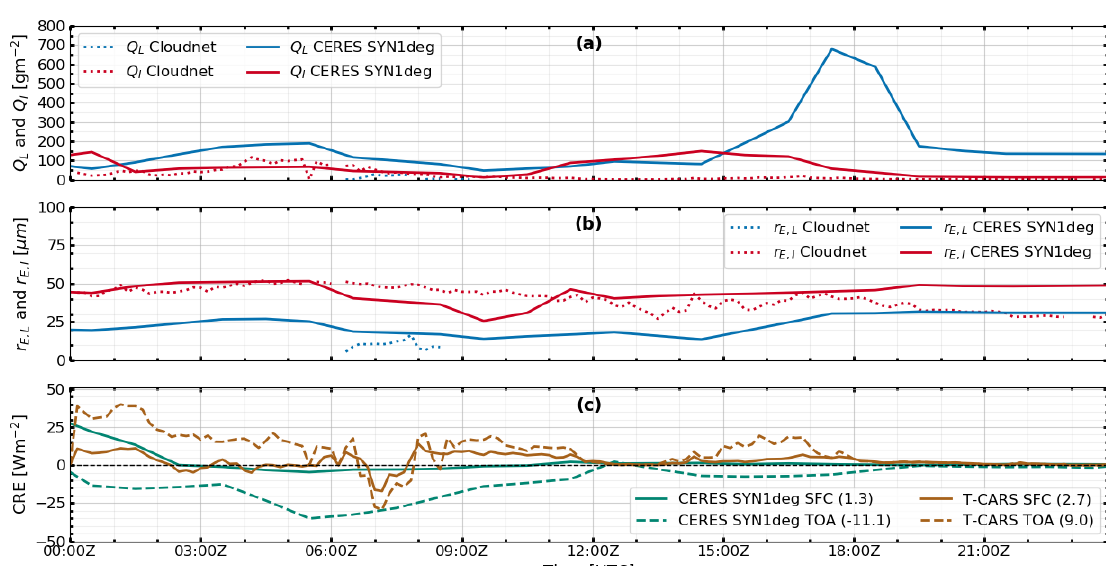
Figure 9. Time series of cloud microphysical properties and CRE between CERES SYN1deg and Cloudnet for the 2 July 2017 case. Panel (a) shows the comparison between CERES SYN1deg and Cloudnet of liquid water path ( Q L ; blue) and ice water path ( Q I ; red). Panel (b) shows the liquid effective radii ( r E , L ; blue) and the ice effective radii ( r E , I ; red). Panel (c) shows the cloud radiative effect (CRE) at the surface (SFC; solid lines) and the top of the atmosphere (TOA; dashed lines) from T-CARS (brown) and CERES SYN1deg